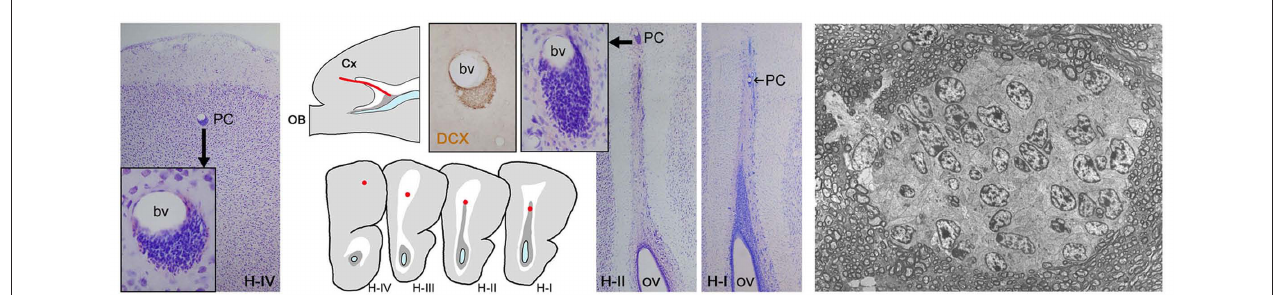
Figure 1 | A parenchymal chain of neuroblasts (PC) in a 6-month-old rabbit. After reconstruction, the chain is followed along a blood vessel (bv) through the white matter of the corpus callosum and in the frontal cortex (Cx). On the